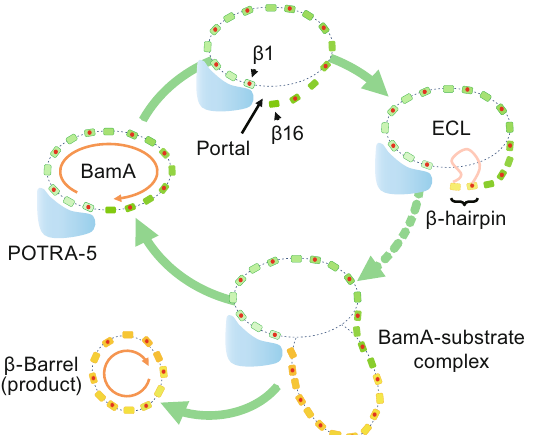
Figure 2. Schematic of the mechanism of β -barrel assembly. Each β -barrel is presented by a group of β -strands, and is viewed from the extracellular space. Each β -strand is represented by a rectangle, and those β -strands whose C-termini point to the extracellular space (i.e., odd-numbered strands) are marked with an additional red dot. The strands of BamA are colored light to bright green from the N- to C-termini, respectively. POTRA-5 (cyan) is N-terminal to the β 1 strand, and it serves as the site for β -hairpin formation. The strands of the newly assembled substrate β -barrel are colored yellow to orange from the N- to C-termini, respectively. The orange curve represents an extracellular loop (ECL) of the β -barrel substrate. The overall rotation of the β -barrel peptide, as viewed from the extracellular space, is clockwise (brown